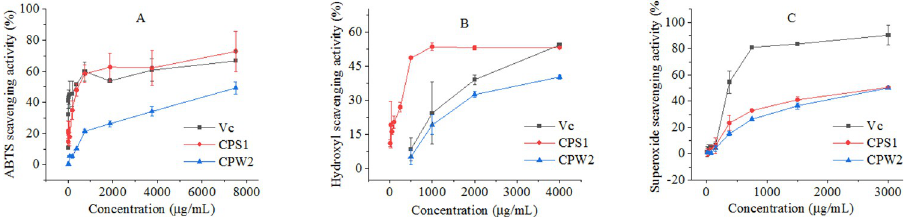
Fig 8. Scavenging activities for ABTS (A), hydroxyl (B), and superoxide (C) radicals of CPS1, CPW2, and Vc.